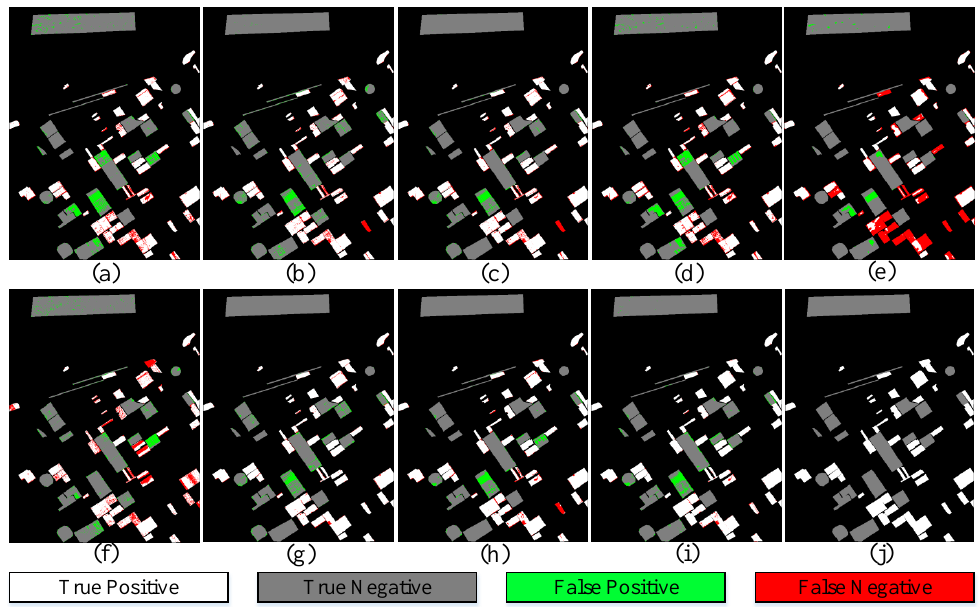
Figure 8. The visual results of different methods on the Barbara dataset: ( a ) CVA [61], ( b ) KNN, ( c ) SVM, ( d ) RCVA [39], ( e ) DCVA [50], ( f ) DSFA [51], ( g ) GETNET [6], ( h ) TDSSC [20], ( i ) our ASSCDN, and ( j ) Reference image.